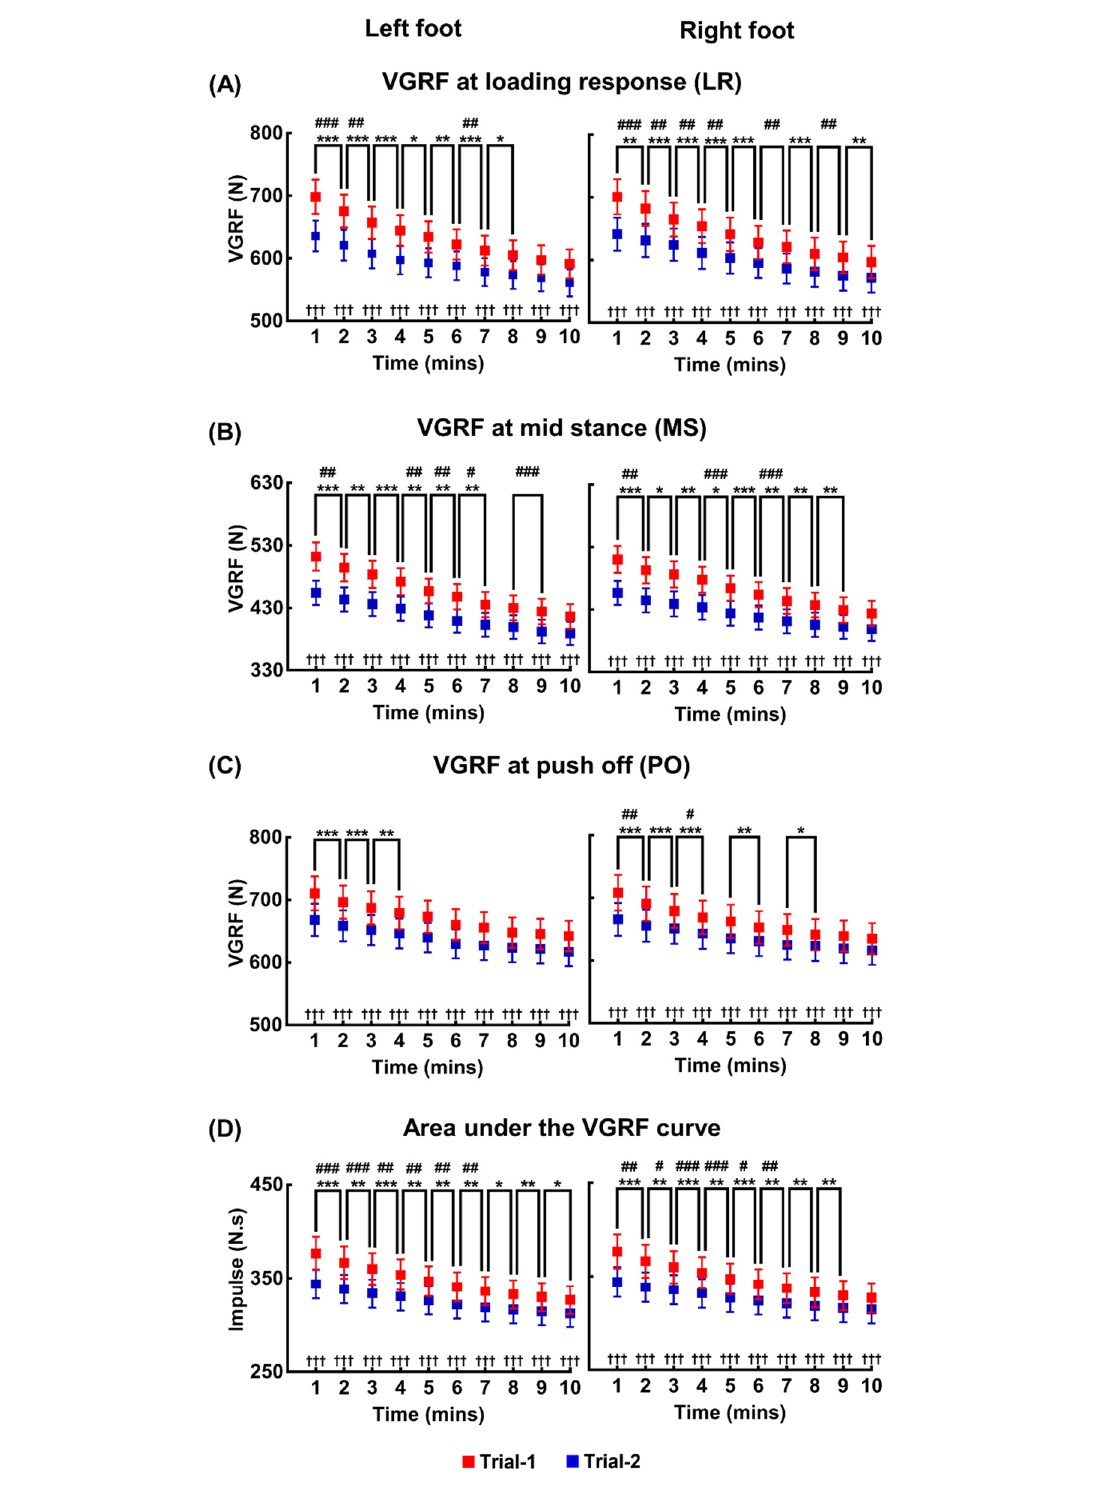
Figure 2. Changes in the VGRFs at the three stereotypical time points and the impulse due to VGRF with increase in time. ( A – C ) show the means and standard error bars of VGRFs for 20 participants at LR, MS, and PO, respectively, averaged over every one-minute time interval for the both feet and two trials. ( D ) shows the means and standard error bars of impulse for 20 participants averaged over every one-minute time interval for the both feet and two trials.